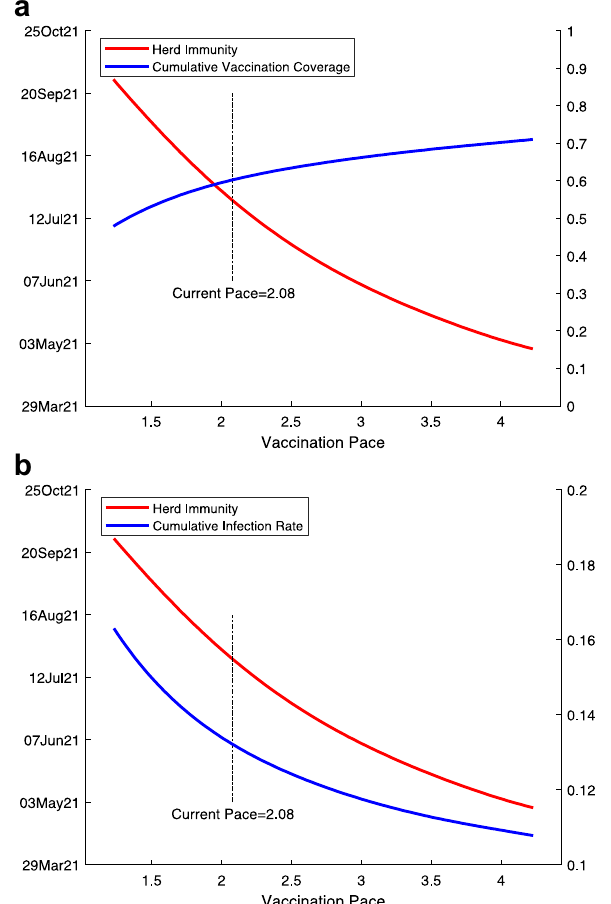
Figure 4. Estimated herd immunity date, cumulative vaccination coverage, and cumulative infection rate with different vaccination pace. Herd immunity date is predicted using first-dose vaccine effectiveness and first- dose vaccination pace (see "Methods"). Vaccination pace is the number of vaccine doses administered per 100 people per week. Until the first week of March 2021, the average pace over time is 2.08 doses per 100 people per week. The red curve is the predicted herd immunity date (left y-axis) in both ( a ) and ( b ). The blue curve is the estimated cumulative vaccination coverage in the population (right y-axis) when herd immunity is achieved in a and the estimated cumulative infection rate (right y-axis) in ( b